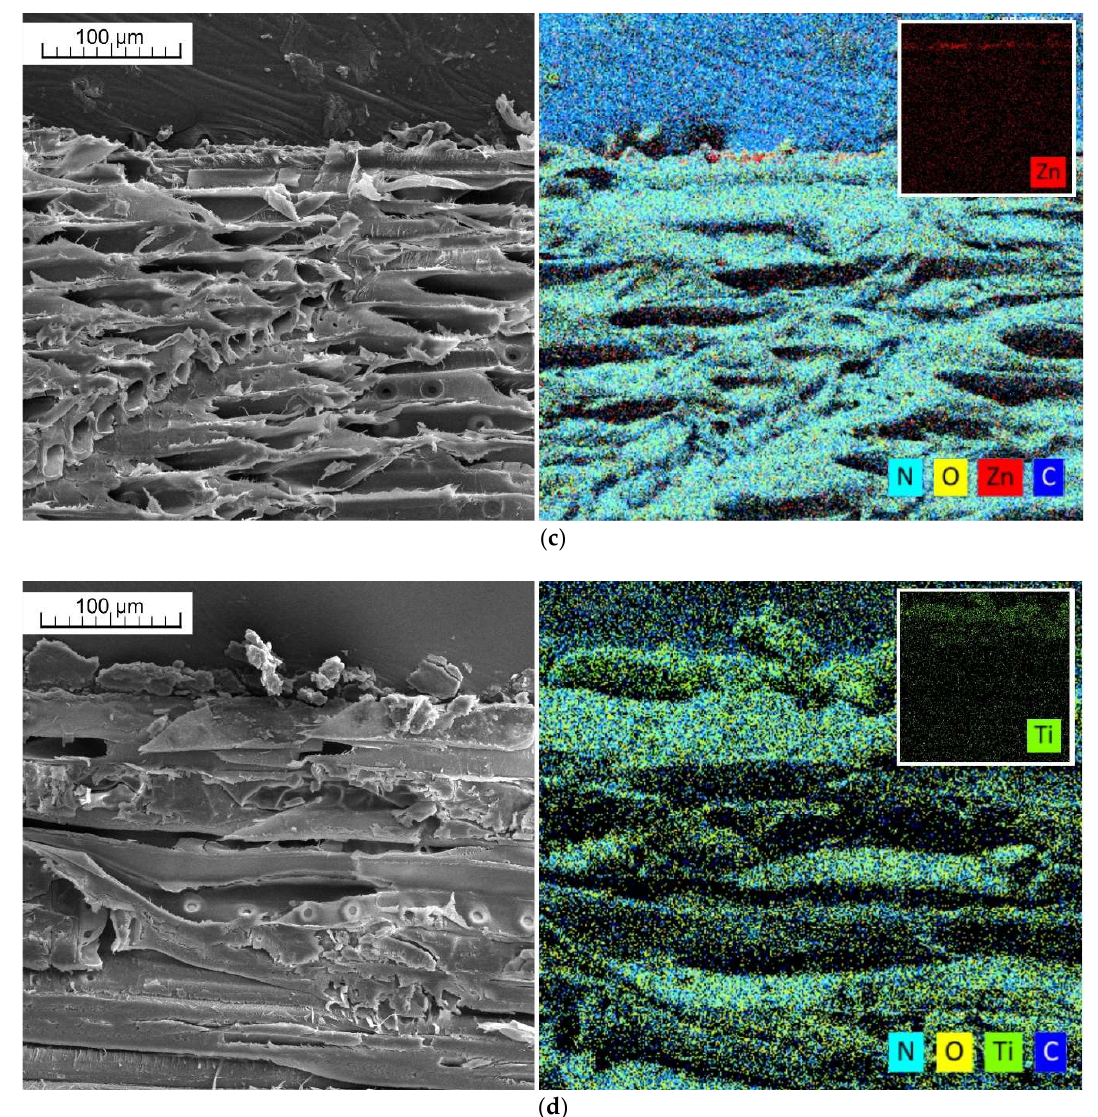
Figure 3. SEM and elemental microscopic analyses of surface treated wood. ( a ) Surface of larch wood treated by T7 formulation—nitrogen (N) is a compound of HALS and titanium nanoparticles (Ti) was applied as TiO 2 ; ( b ) Cross section of larch wood samples—a combination of zinc nanoparticles (Zn) and titanium nanoparticles (Ti) was applied as treatment T5, deposited only on the surface of the larch wood tracheids; ( c ) Zinc nanoparticles (Zn) applied as ZnO using treatment T6 are deposited only on the surface of the larch wood tracheids; ( d ) Titanium nanoparticles (Ti) applied in treatment T7 are deposited only on the surface of the larch wood tracheids.